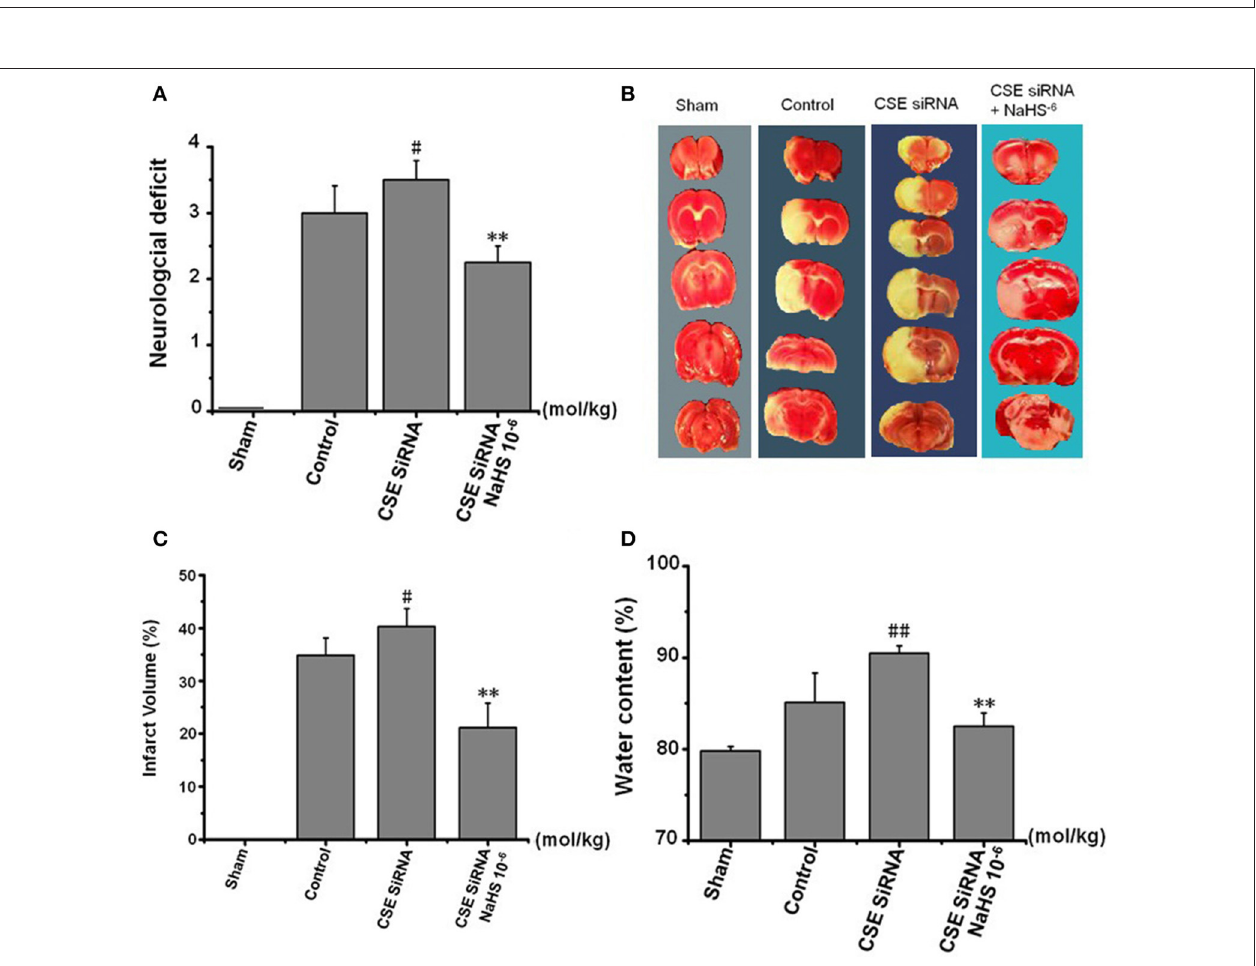
FIGURE 5 | Effect of CSE knockdown (CSE siRNA) on neuronal injury induced by MCAO in rats (Mean ± SEM, n = 8). (A) Neurological deficits. (B) Infarct volume. (C) Quantitative analysis of brain infarct volume. (D) Brain water content. # P < 0.05 vs. control, ## P < 0.01 vs. control, ** P < 0.01 vs. CSE siRNA.